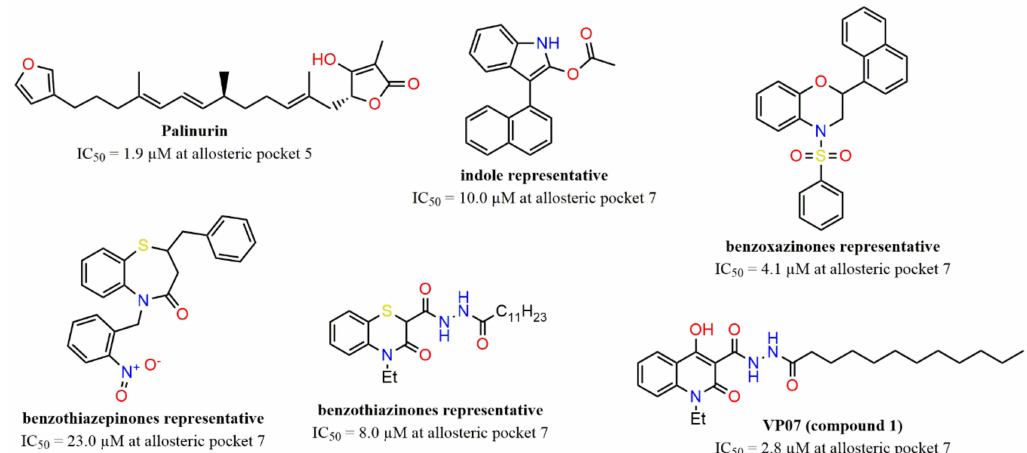
Figure 2. Representation of different classes of GSK-3 β allosteric inhibitors potentially binding to corresponding